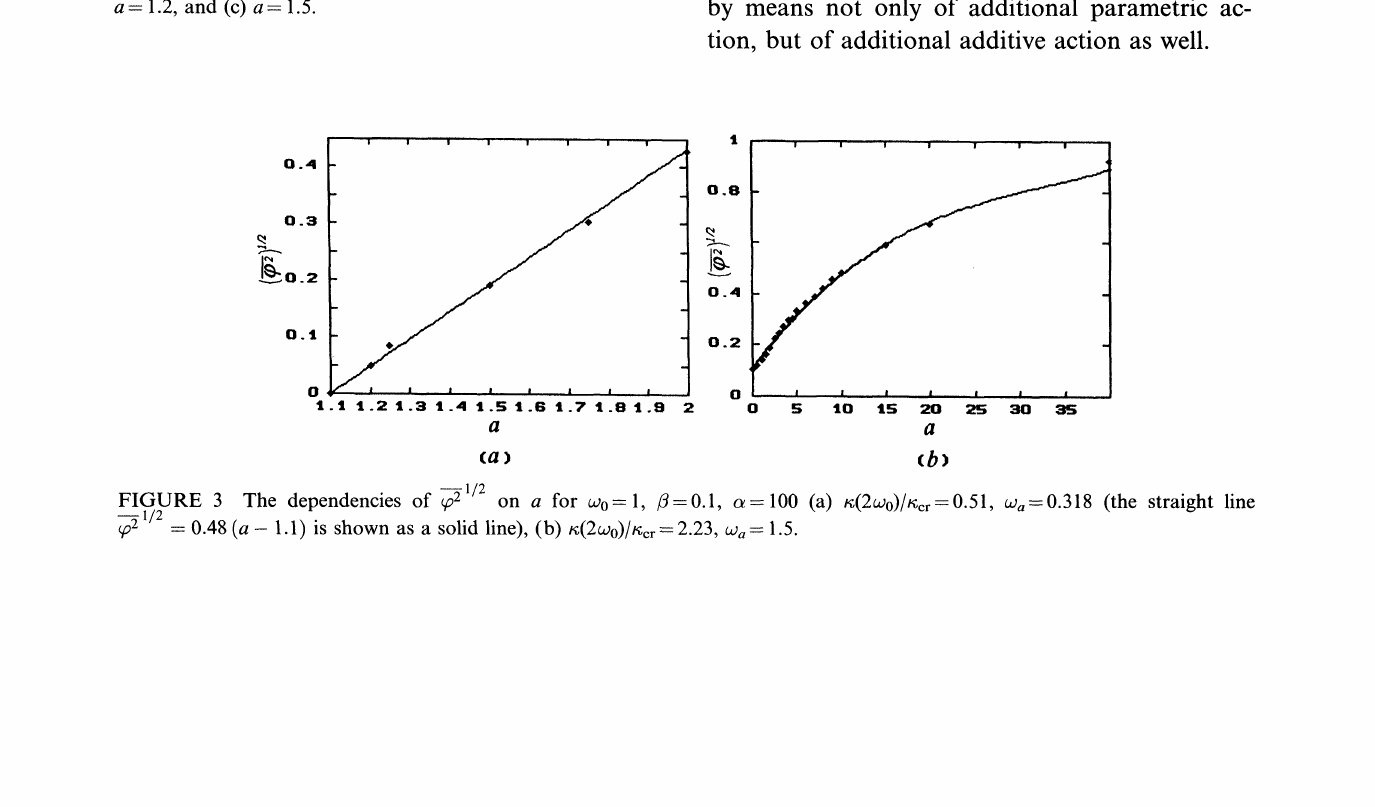
FIGURE 2 The dependencies o(t) and qb(t) for wo=l, /3:0.1, c= 100, (2o0)/cr=0.51, w,:0.318 (a) a= 1.12, (b) a-- 1.2, and (c) a-- 1.5.